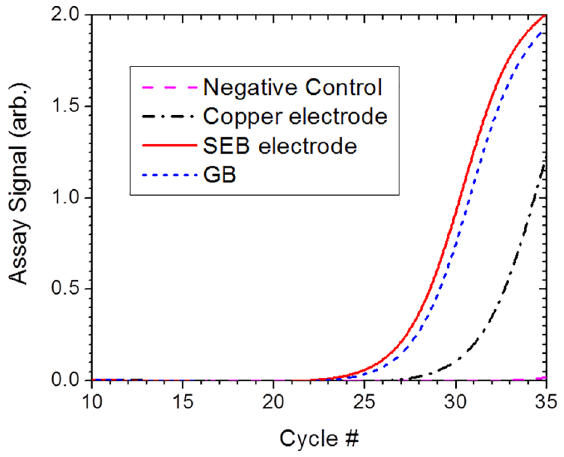
Figure 13. E-Lysis efficiency, with respect to nucleic acid assay, in channels with SEB and copper electrodes. The electrical lysis efficiencies of E-Lysis chambers using SEB and copper electrodes were compared by determining the amount of released ribosomal RNA from RT-PCR assay performed on the cell lysate.